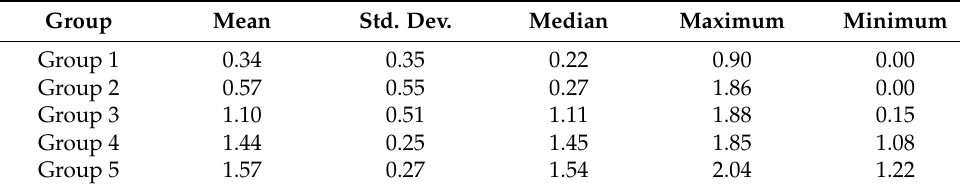
Table 4. Emissions of thermal origin per household, in tCO 2 /year. Group Mean